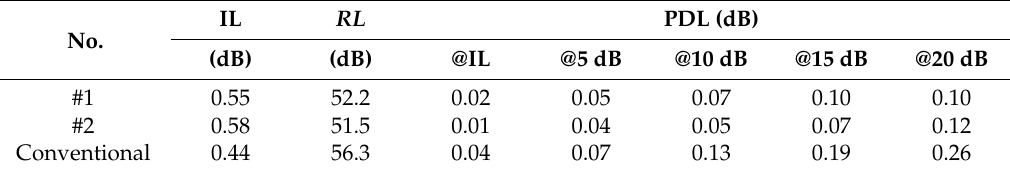
Table 4. Measured specifications of the new samples and a conventional MEMS VOA.